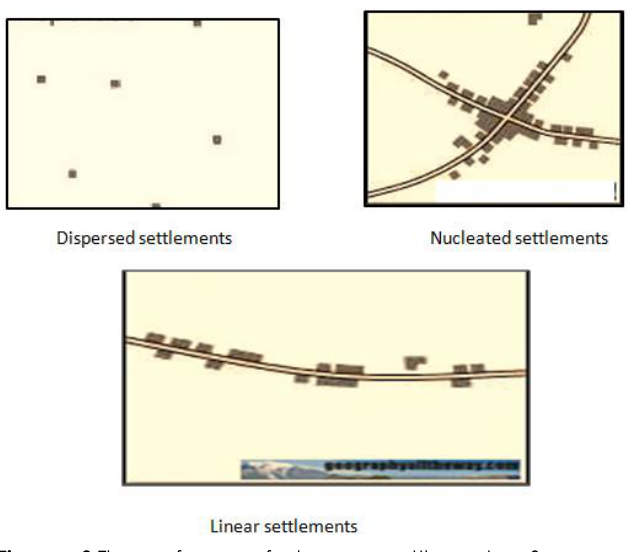
Figure 3. Three forms of human settlements. Source: